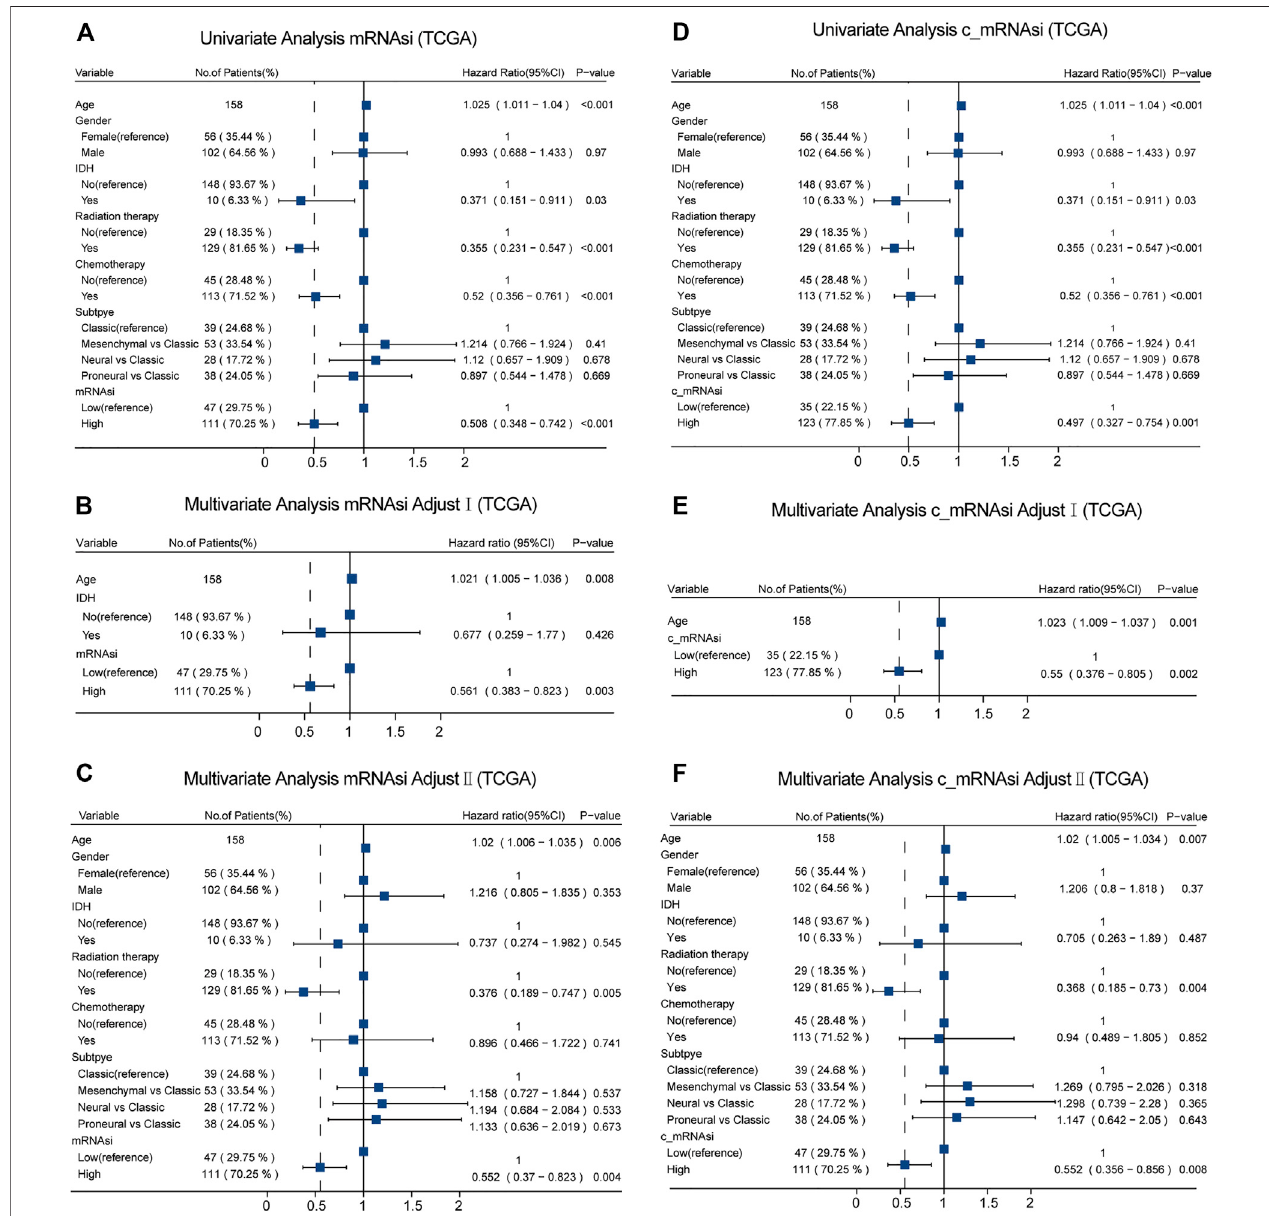
FIGURE3| ForestplotsofunivariateandmultivariateCoxregressionanalysisinTCGA. (A) .UnivariateCoxregressionanalysisofmRNAsiinTCGA. (B) .Multivariate Cox regression analysis of mRNAsi adjusted I model in TCGA. (C) . Multivariate Cox regression analysis of mRNAsi adjusted II model in TCGA. (D) . Univariate Cox regression analysis of c_mRNAsi in TCGA. (E) . Multivariate Cox regression analysis of c_mRNAsi adjusted I model in TCGA. (F) . Multivariate Cox regression analysis of c_mRNAsi adjusted II model in TCGA.